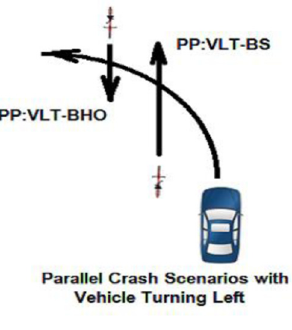
Figure 7 Crash geometry of PP:VLT scenarios